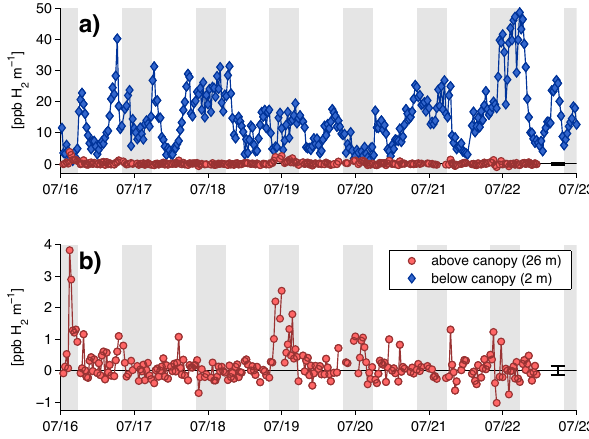
Figure 6. Example of mole fraction gradients of hydrogen (ppbH 2 m − 1 ) above (26m) and below (2m) the forest canopy: (a) both levels compared side by side in the same scale and (b) above canopy at a magnified scale. Black whiskers represent instrument precision (median 1 σ bracketed precision scaled over the vertical distance in ppbH 2 m − 1 ) . Gray shading designates nighttime hours.